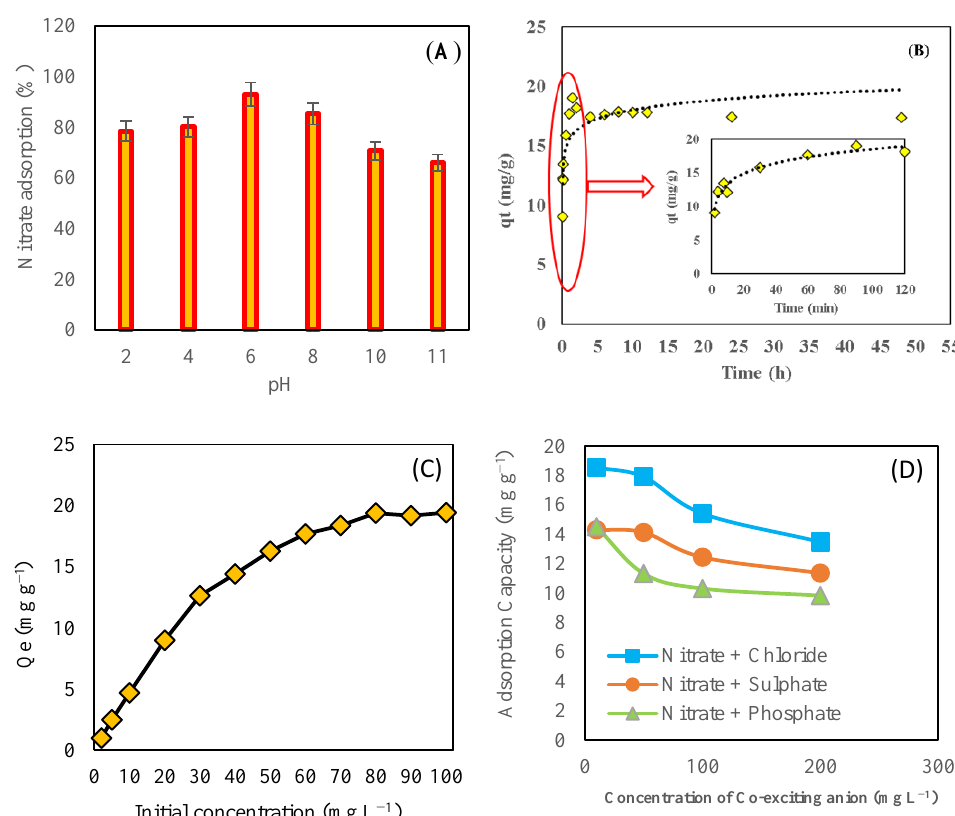
Figure 6. ( A ) Effect of solution pH, ( B ) effect of contact time, ( C ) effect of initial nitrate concentration, and ( D ) effect of co-existing anions on adsorption capacity SMCB/Fe.